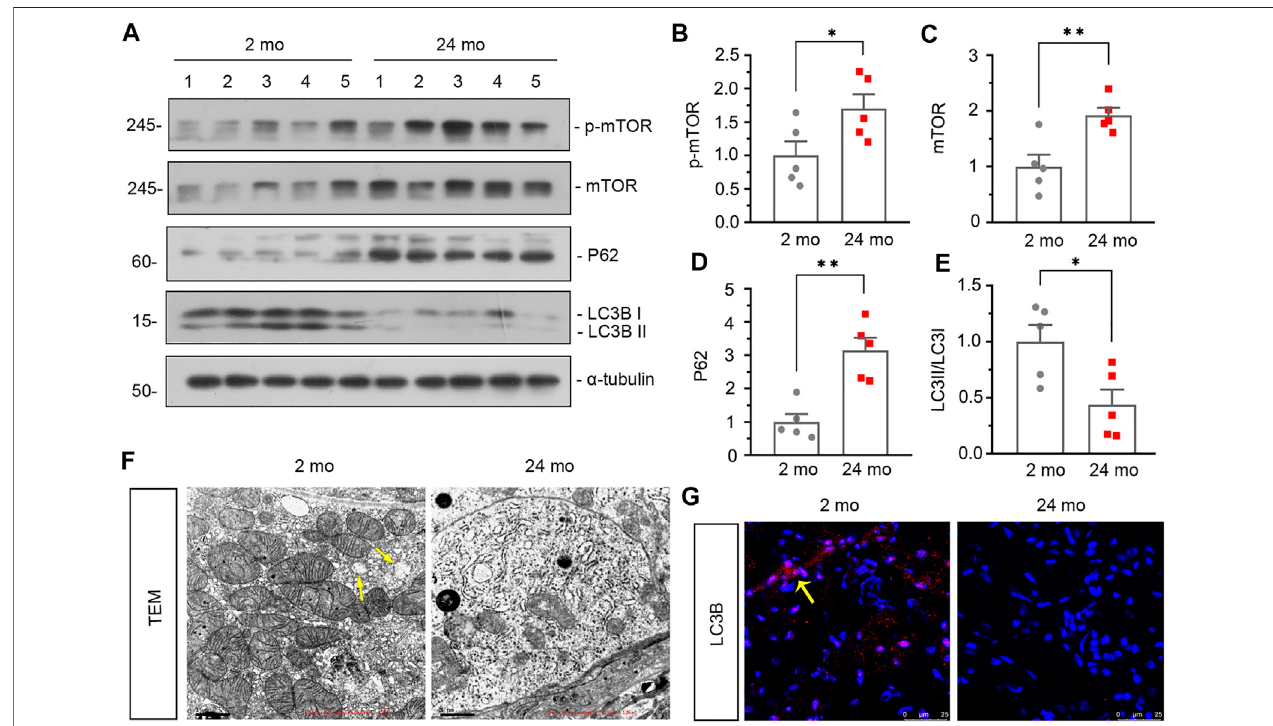
FIGURE 2 | Aged kidney is associated dysfunction of autophagy. (A – E) Representative western blot and quantitative data showing renal expression of p-mTOR, mTOR, P62 and enhanced LC3-IIformationin 2-month-old and 24-month-old mice. Numbers (1 – 5) indicate each individual animalin each given group. * p < 0.05, ** p < 0.01 versus 2-month-old mice group. (F) Representative transmission electron microscopy (TEM) micrographs showing mitochondrial ultrastructure morphology and autophagic vacuole in ultrathin kidney sections. Arrow indicates autophagic vacuole. Scale bar, 1 μ m. (G) Representative micrographs showing LC3B expression in kidneys in 2-month-old and 24-month-old mice. Cryosections were subjected to fl uorescence staining for LC3B. Arrows indicate positive staining.